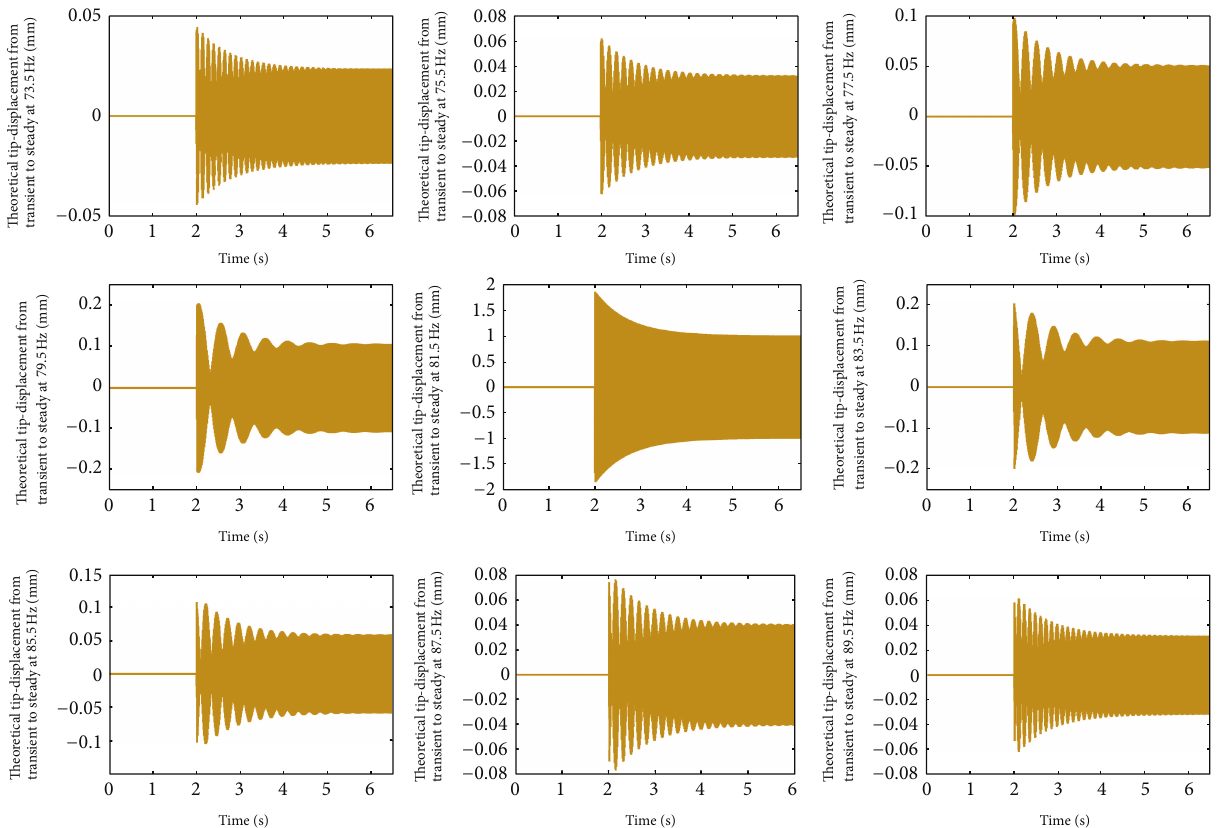
Figure 11: Theoretical tip displacement responses with the second-type mode shape of the beam from transient to steady state.